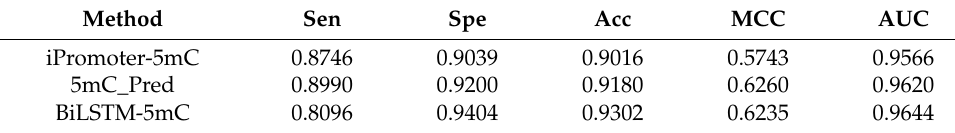
Table 2. Performance comparison on the training dataset by using the 5-fold CV.